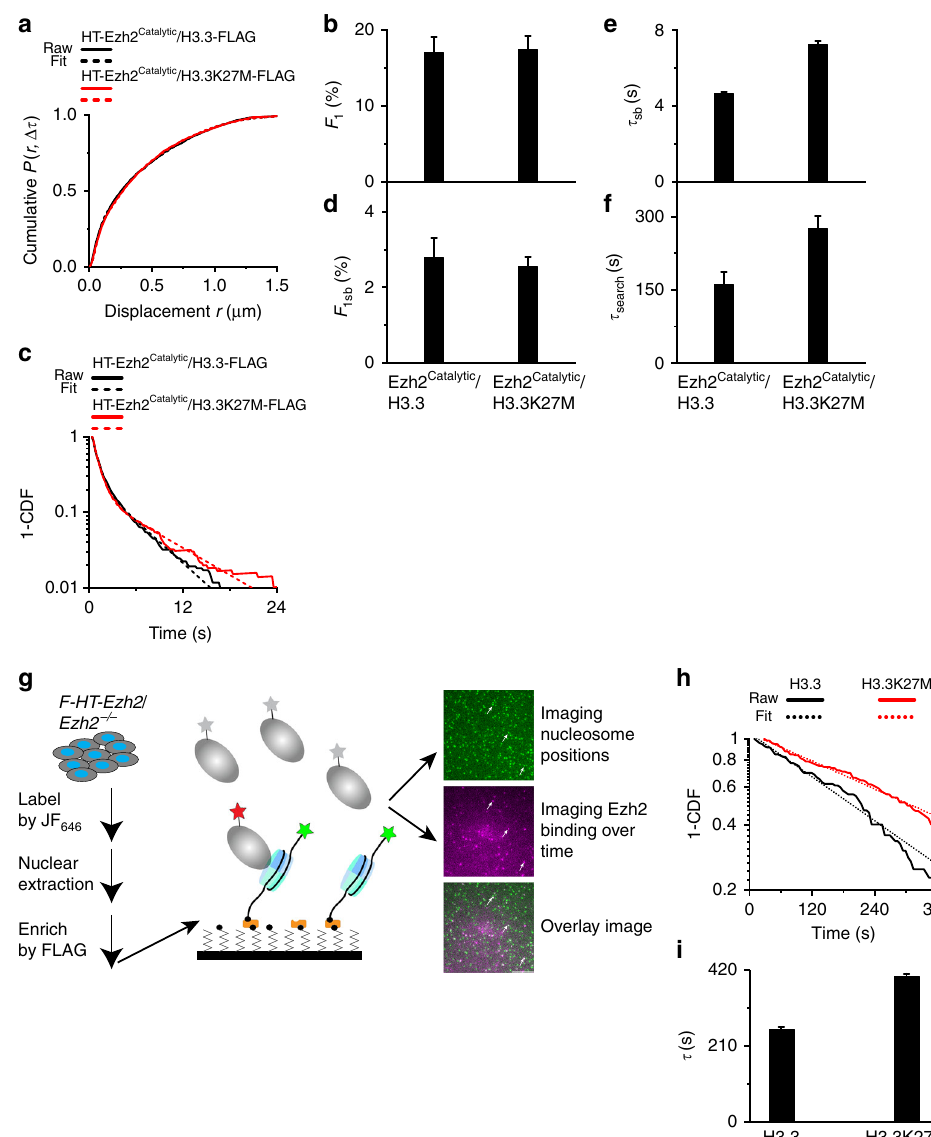
Fig. 6 The interactions between H3.3K27M and Ezh2 stabilize Ezh2 on chromatin. a Cumulative distribution of displacements for HaloTag-Ezh2 Catalytic in HEK293T cells expressing H3.3-FLAG ( N = 42 cells, n = 2365 displacements) or H3.3K27M-FLAG ( N = 36 cells, n = 4120 displacements). The cumulative distributions were fi tted with three populations. Ezh2 Catalytic contains only the catalytic lobe (Fig. 3a). Fitted parameters are shown in Supplementary Table 7. b Fraction of the chromatin-bound population ( F 1 ) obtained from a . Results are means± SD. c Survival probability distribution of the dwell times for HaloTag-Ezh2 Catalytic in HEK293T cells expressing H3.3-FLAG ( N = 56 cells, n = 1412 displacements) or H3.3K27M-FLAG ( N = 46 cells, n = 1042 displacements). The distributions were fi tted with a two-component exponential decay model. Fitted parameters are shown in Supplementary Table 8. d – f Fraction ( d ), residence time ( e ), and search time ( f ) of the long-lived population ( F 1sb ) for HaloTag-Ezh2 Catalytic in HEK293T cells expressing H3.3-FLAG or H3.3K27M-FLAG . Results are means ± SD. g In vitro single-molecule binding assay. FLAG-HaloTag-Ezh2 ( F-HT-Ezh2 ) was expressed stably in Ezh2 ─ / ─ mES cells and labeled by JF 646 dyes. FLAG-HaloTag-Ezh2-PRC2 was one-step enriched by FLAG antibody and loaded into the fl ow cells. Nucleosome labeled with Alexa Fluor ® 488 was tethered to the surface of a coverslip that had been passivated and functionalized with NeutrAvidin. The position of individual nucleosomes was recorded (green image). We followed the duration of FLAG-HaloTag-Ezh2-PRC2 on nucleosome (magenta image). The colocalization of nucleosome and FLAG-HaloTag-Ezh2 indicates a binding event (overlay image). Arrowheads indicate binding events. Scale bar, 5.0 µ m. h Survival probability distribution of the dwell times for FLAG-HaloTag-Ezh2-PRC2 on H3.3-nucleosome ( n = 99 trajectories) and on H3.3K27M-nucleosome ( n = 115 trajectories). The distributions were fi tted with a one-component exponential decay model. i Residence time of FLAG-HaloTag-Ezh2-PRC2